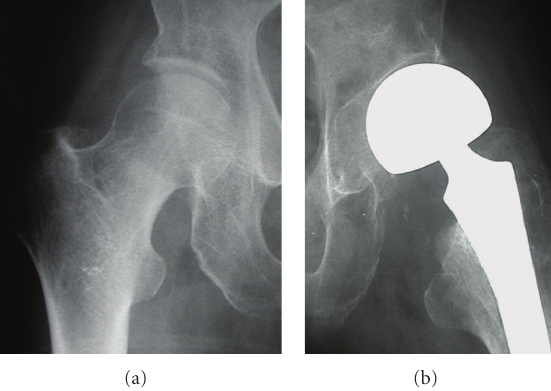
Figure 3: Subluxation of the outer head is apparent. The superior part of the acetabulum shows compression and the inclination of acetabular subchondral bone is increased compared with that on the right